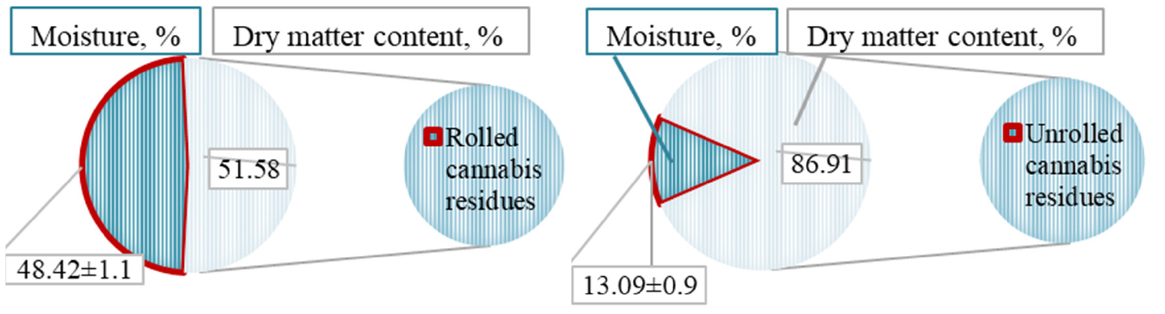
Figure 4. Moisture of rolled and unrolled cannabis residues.